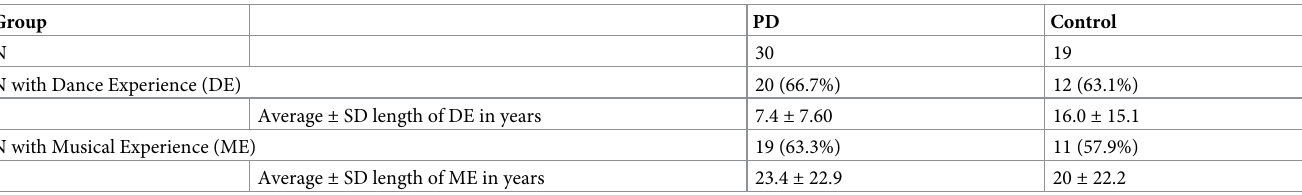
Table 1. Subject characteristics for PD and control groups.